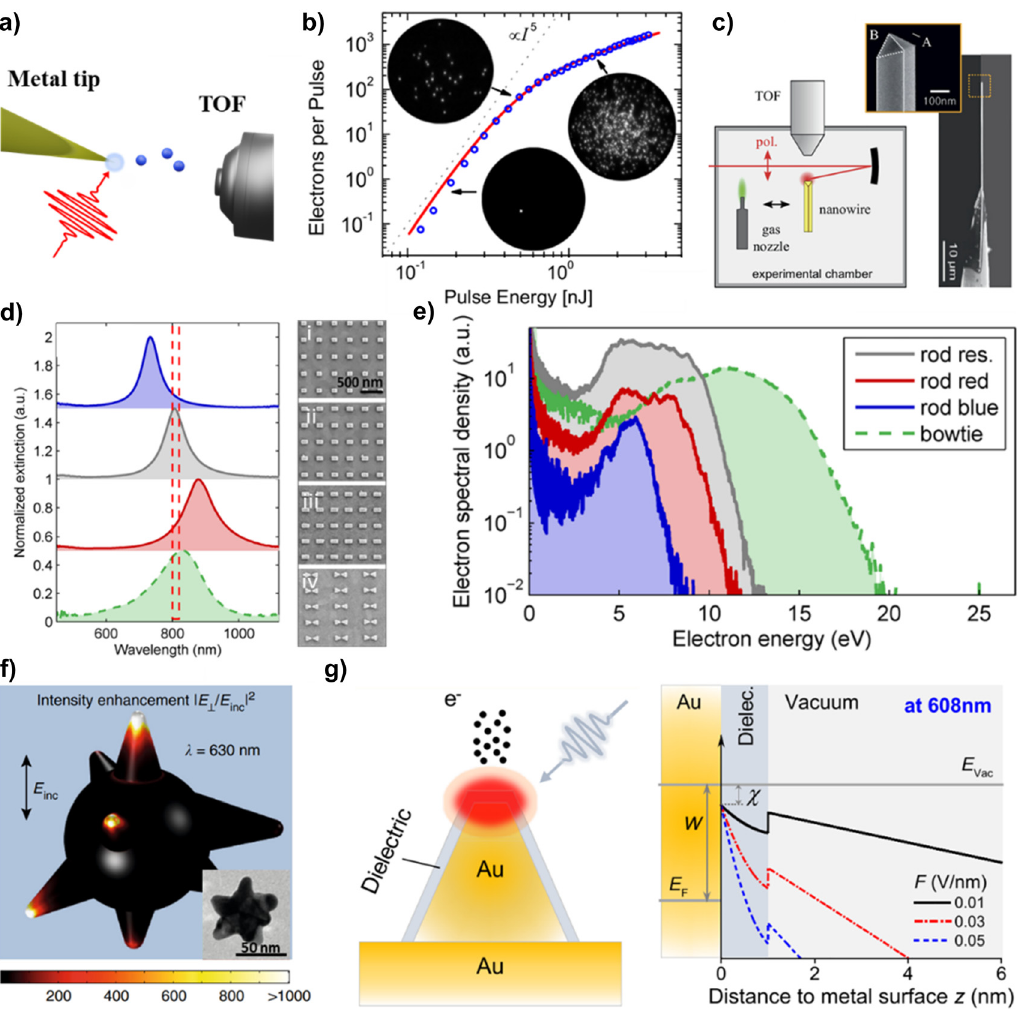
Figure 13: Plasmonically enhanced photoelectron emission. (a)Schematicofphotoelectronsemittedfromasharpmetallictipbytakingadvantageoftheplasmonicresonance,analyzedbyatime-of-flight electron (TOF) spectrometer. The strong plasmonic field accelerates the emitted photoelectrons and tailors their dynamics [180]. (b) Pulse energy dependence tip-enhanced photoelectron yields per pulse as a function of the input pulse laser energy (blue circle). The strong fi eld effect induces an abrupt transition with the 5th power-law line (black dashed line). Adapted with permission from ref. [181]. Copyright 2010, APS (c) Schematic of photoelectron emission from single-crystalline Au nanowires, for the electrons with higher kinetic energy. SEM image of singlecrystallineAunanowires.Adaptedwithpermissionfromref.[182].Copyright2017,AIP.(d)MeasuredextinctionspectraandSEMimages fornanorodswithdimensionsof(i)120 × 87 × 40nm 3 ,(ii)152 × 87 × 40nm 3 ,(iii)183 × 87 × 40nm 3 ,andforabowtiestructurewithdimensions of (iv)lengthof 260nm,a widthof 90nm, andheightof40 nm[183].(e)Electronspectrafordifferentnanostructuregeometriesandfora laser peak intensity of 25 . 1 × 10 9 W/cm 2 . Adapted with permission from ref. [183]. Copyright 2013, ACS. (f) numerical simulation of the localized near- fi eld distribution of a single nanostar upon vertical polarization. TEM image of a single nanostar with a 50 nm scale bar [184]. (g) Schematicof enhanced photoemission from an ultrathin dielectric coated Au pyramid structure. Potential barrier pro fi le of a dielectric coated Au pyramid structure with different external fi elds (F). Adapted with permission from ref. [185]. Copyright 2020,